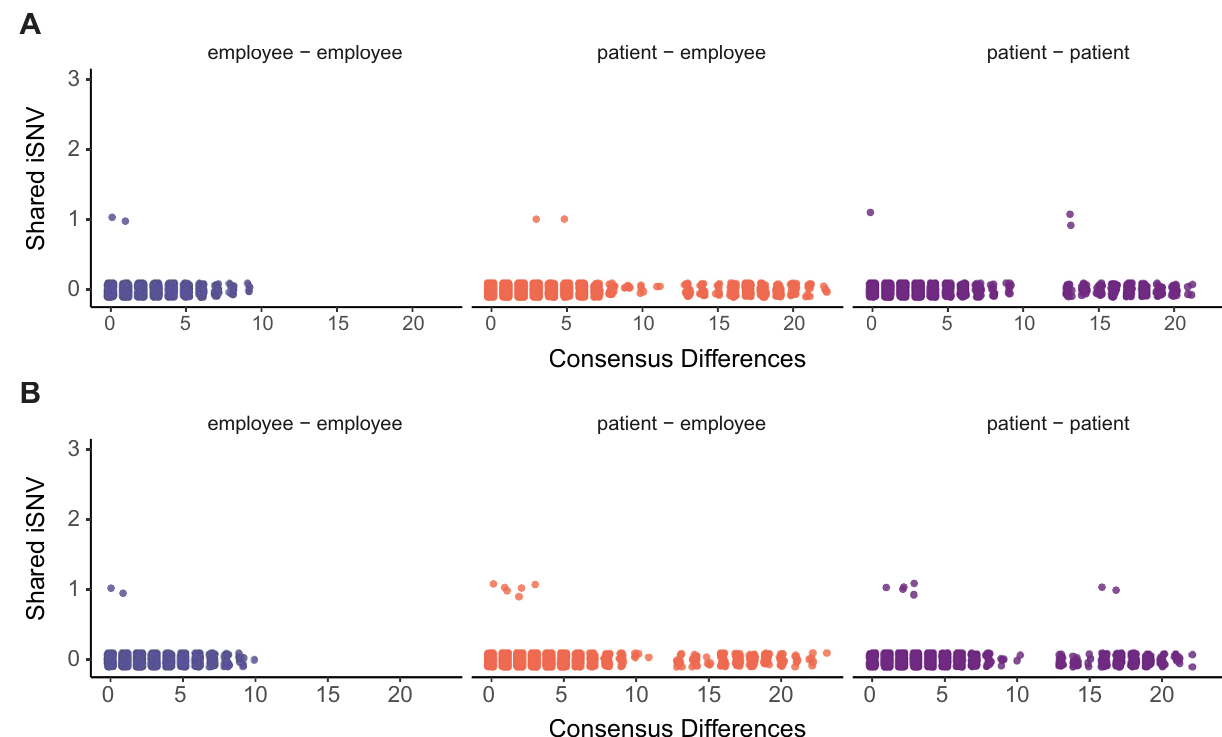
Fig 5. Pairwise comparisons of shared iSNV. Each unique pair is shown as a single point, with employee-employee pairs in violet (left), patient-employee pairs in orange (middle), and patient-patient pairs in purple (right). The number of iSNV shared by each pair is shown on the y-axis with the number of consensus differences between the pair of genomes on the x-axis. Pairs of samples collected within seven days of each other are displayed in (A), and pairs of samples collected greater than seven days apart are shown in (B).